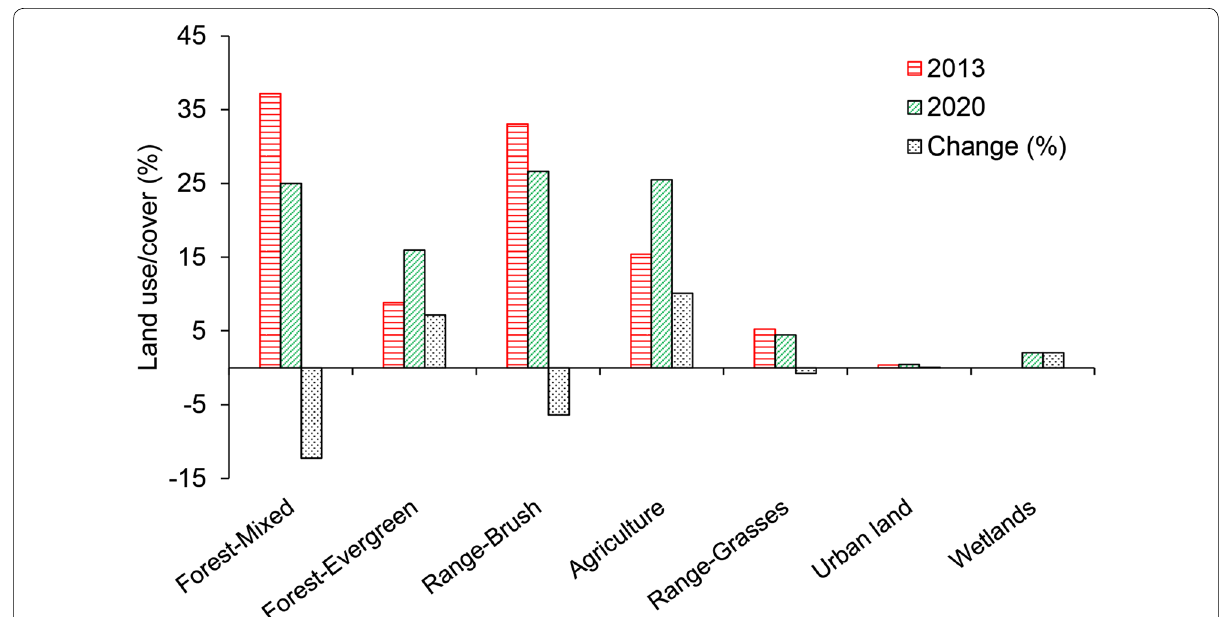
Fig. 18 Land use/cover of the baseline (2013), future (2020) period and their changes